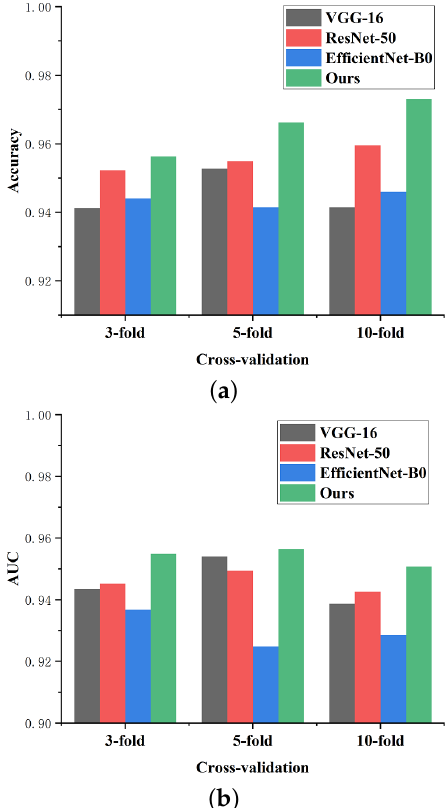
Figure 15. Comparison of cross-validation performance for different methods on dataset BT-2C. ( a ) Accuracy comparison, ( b ) AUC